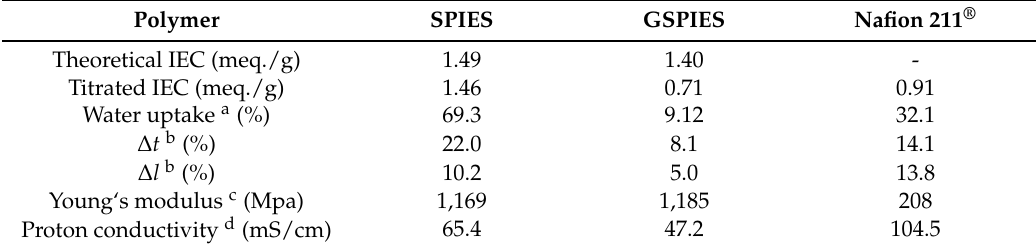
Table 1. Properties of sulfonated and grafting polymer and Nafion211 ® .